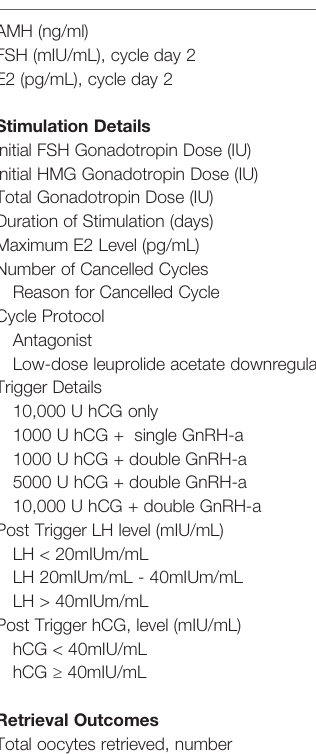
TABLE 3B | Oocyte Cryopreservation Outcomes for All AYA Transmale Cycles. Baseline Hormonal Laboratory